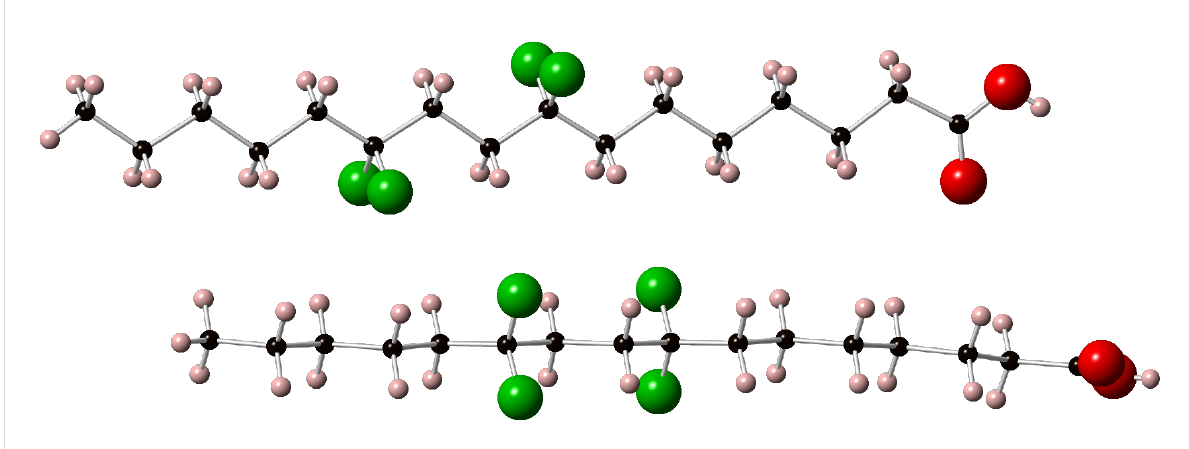
molecules as they appear within the unit cell are presented in the image, allowing a view from above and to the side of the extended chain. The closest CF···HC contacts are 2.88 Å in 6a and 2.85 Å in 6c , much longer than any meaningful organic fluorine hydrogen bond [21]. The C–CF 2 –C angle in 6a (Figure 5) is 117° and as expected, wider than the other C–CH 2 –C angles which are typically ~112.5°. For 6c (Figure 6) the C–CF 2 –C angles are 115.6° (at C-8) and 116.3° (at